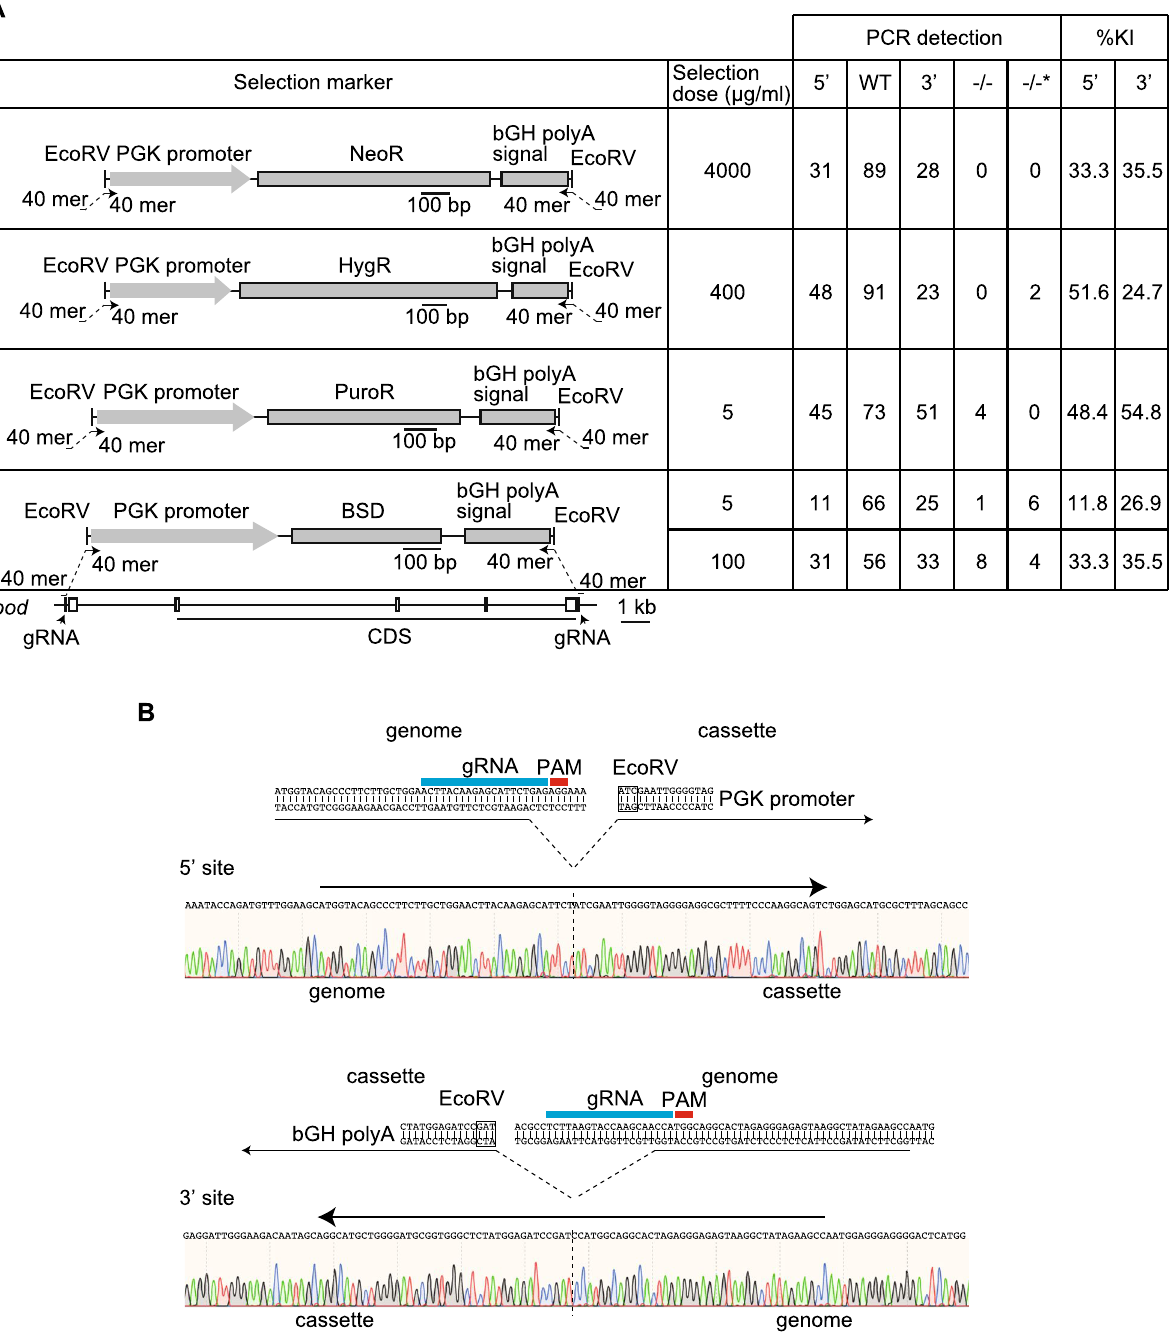
Figure 2. SUCCESS induced homozygotic deletion of the target gene. ( A ) The design of the selection markers is shown. Knock-in efficiency of the selection marker were calculated using genotype results of 93 clones. Arrows show 80mer ssODNs consisting of a 40mer homology sequence to the target genomic region and another 40mer homology sequence to the cassette with selection marker. The tables indicate the results of genotyping of 93 clones. BSD, blasticidin S resistant gene; HygR, hygromycin resistant gene; NeoR, neomycin resistant gene; PuroR, puromycin resistant gene. ( B ) The schema of ligation between the target genomic region and the cassette with selection marker, both at 5 ′ and 3 ′ sites. The ligation was analyzed by direct sequencing. 5 ′ , 5 ′ site between the genomic region and the cassette; 3 ′ , 3 ′ site between the genomic region and the cassette; WT, wild-type allele; −/−, homozygously knockout clones: −/−*, homozygously knockout clones without the detection of 5 ′ or 3 ′ sites ligation between the genomic region and the cassette; %KI, percentage of knock-in in 93